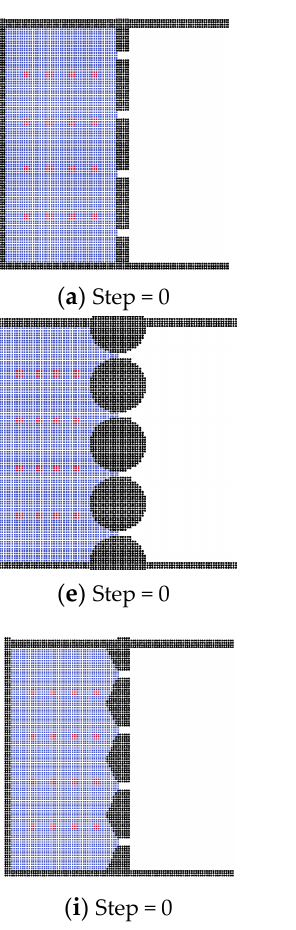
Figure 7. The different oil droplet size systems in membrane for the oil–water separation, ( a , b , e , f , i , j ) forming oil droplets with radii of 4 μ m; ( c , d , g , h , k , l ) forming oil droplets with radii of 8 μ m.